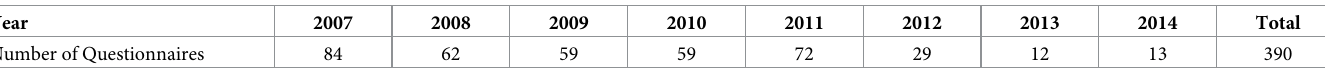
Table 1. Yearly counts of completed